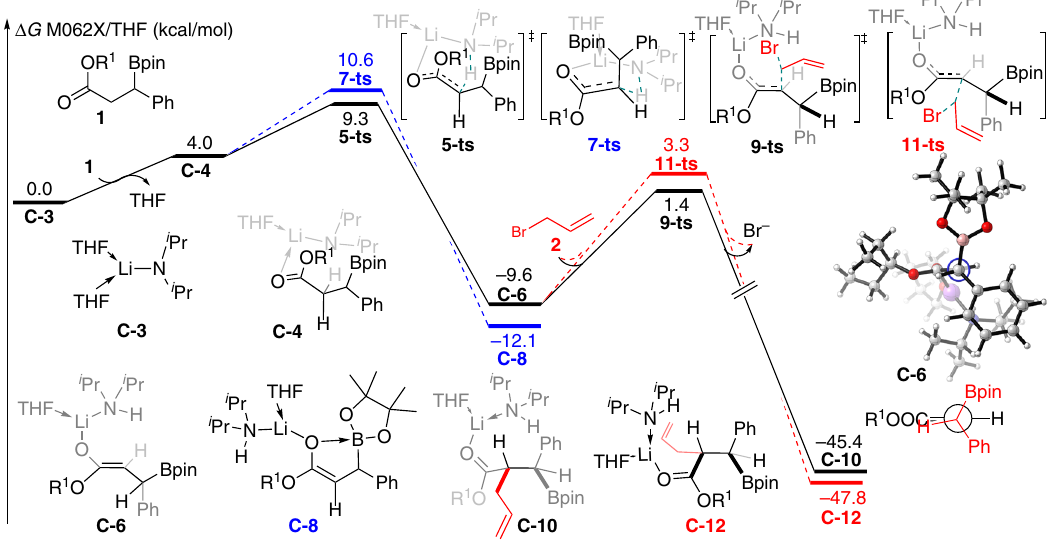
Fig. 3 Calculated free energy pro fi les for the α -alkylation of carbonyl compounds (R 1 = 3-pentyl). The favored pathway is labeled by solid lines. The values given in kcal/mol are the relative free energies calculated by the M06-2X/6-311 + G(d,p)//B3LYP/6-31 G(d) method in THF solvent.